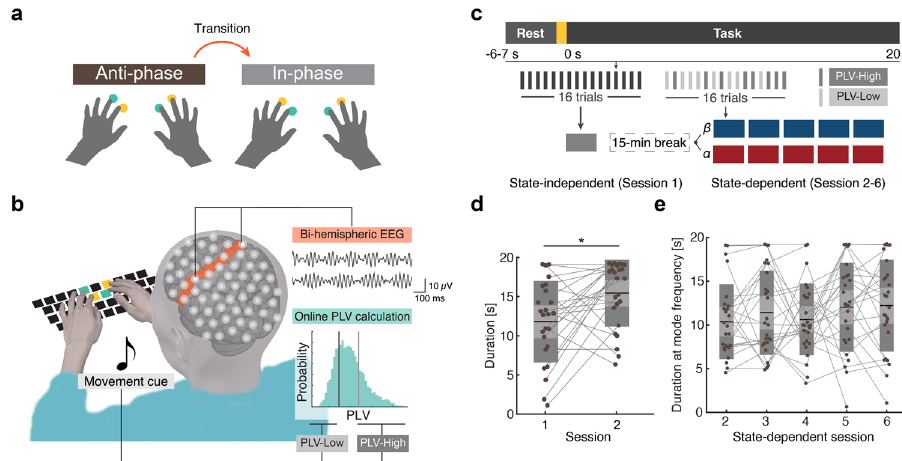
Fig. 1 Anti-phase bimanual tapping task. a Schematic of the behavioral task. b Schematic of the experimental setup. Online acquired scalp EEG signals were processed online to calculate phase-locking values (PLVs) of bi-hemispheric SMR signals. Movement cues were presented if the PLV satis fi ed PLV- High or PLV-Low conditions. c Structure of experiment 1. Top : Time-course of anti-phase bimanual tapping task. The yellow area indicates the ready period whose duration was variable. Bottom : Schematic of the experimental procedure. Participants were allocated to the beta- or alpha-group after a state- independent session and 15-min break. In both groups, participants underwent 5 state-dependent sessions. d Changes in the duration of anti-phase bimanual tapping between sessions 1 and 2. The mean duration of trials at mode frequency in the two sessions was compared using a paired t -test (*: p < 0.05, exact values in the main text). The smaller light and larger dark gray areas represent 95% con fi dence interval and 1 SD, respectively. The black line represents mean values and points connected with gray lines indicate data from each participant. e Changes in duration of anti-phase bimanual tapping among the triggered sessions. The mean duration of trials performed at mode frequency in the fi ve sessions were subjected to one-way